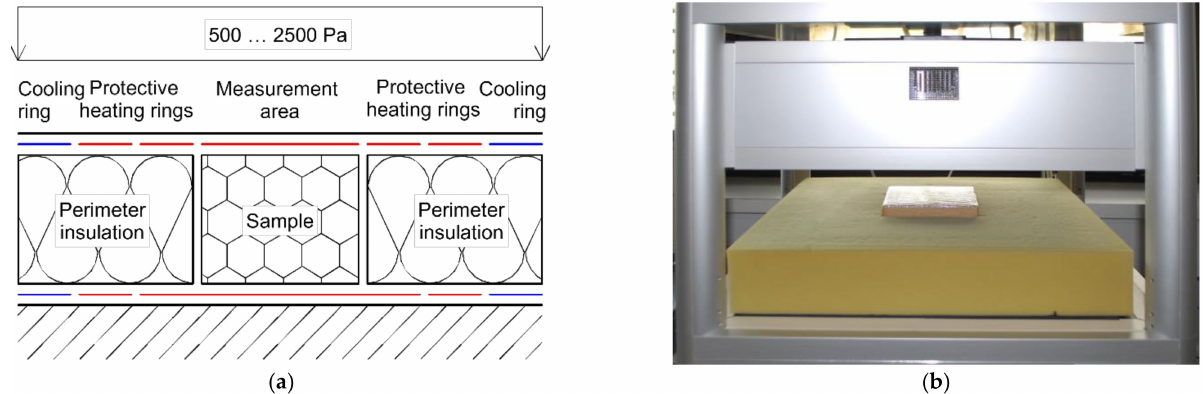
Figure 1. ( a ) Hot plate equipment and ( b ) foam concrete specimen in the measurement device.